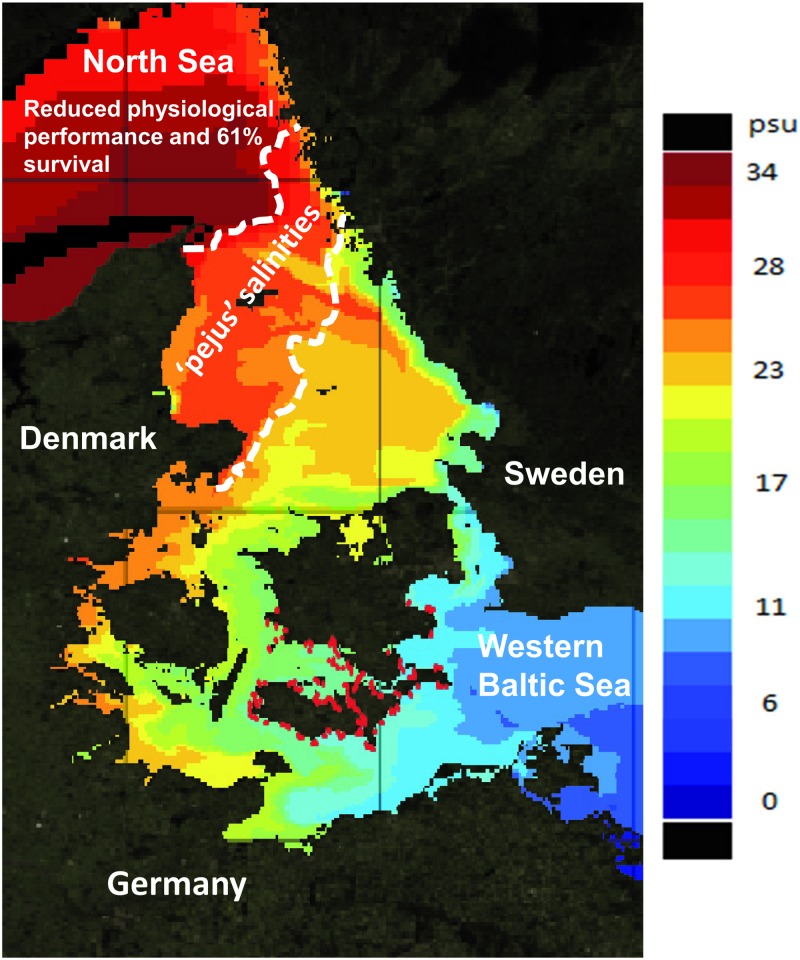
The salinity gradient between the brackish Western Baltic Sea and the full oceanic North Sea, with expected physiological performance and survival of round goby in relation to the ambient salinity.Salinities between approximately 20 and 25 PSU are considered ‘pejus’ salinities, i.e. where things are getting worse, whereas performance is significantly reduced at salinities of 25 PSU and above. Present occurrence (until 2013) of round goby is shown with red dots (modified from Azour et al 2015 [48]).